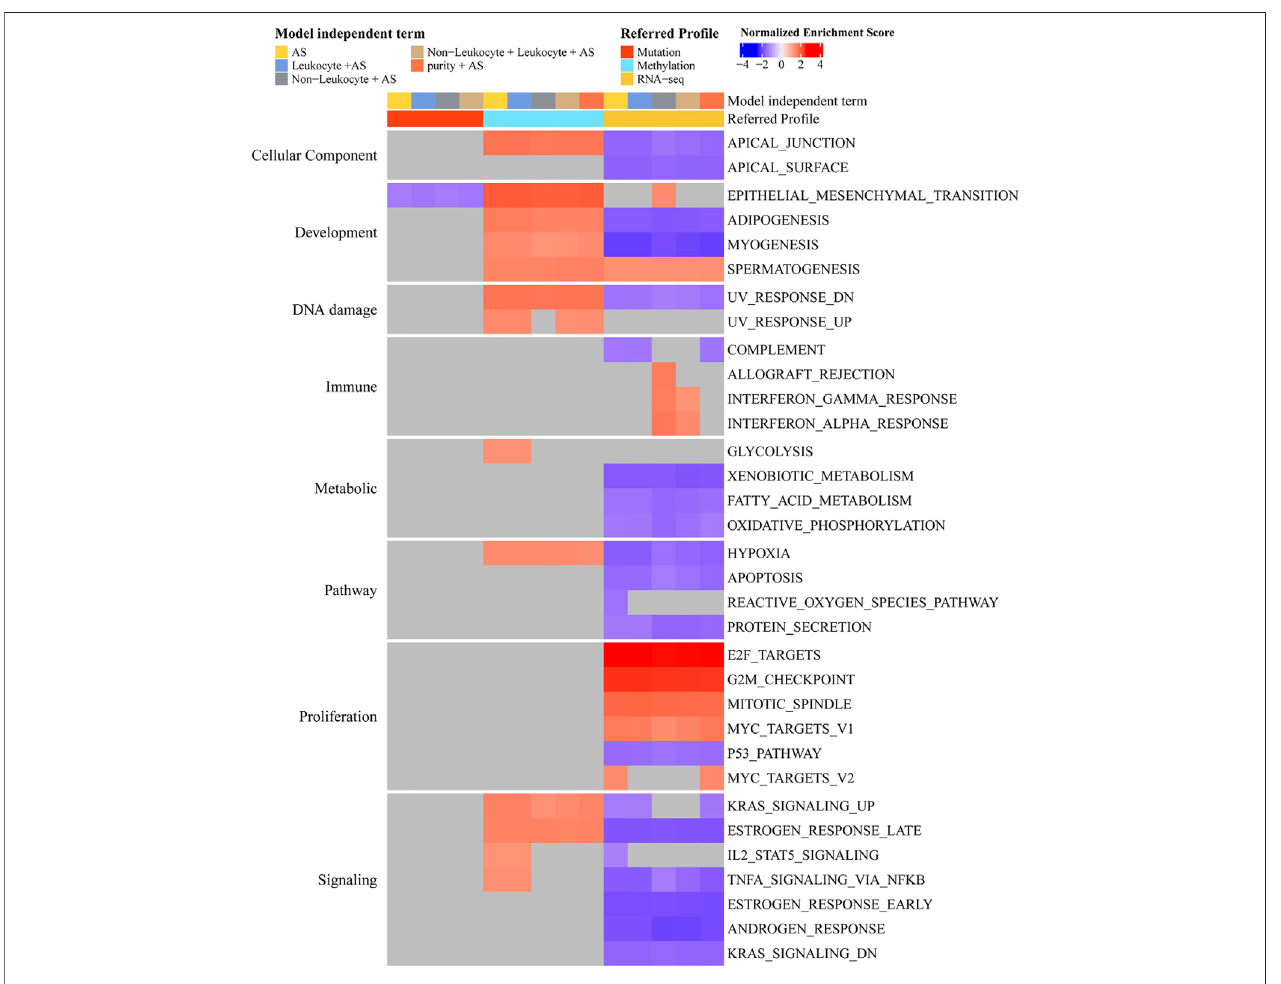
FIGURE 4 | Determination of hallmark function pathway of aneuploidy. Color corresponds to enrichment results of GSEA. Gray means no statistical signi fi cance (adjusted p -value < 0.05).Geneswererankeddecreasinglybasedoncoef fi cientsofASfromlogisticregression(mutationpro fi le)orlinearregression(methylationorgene expression pro fi le); these ordered genes were further entered into GSEA algorithm. By adding purity, leukocyte fraction, or non-leukocyte stroma fraction into model- independent terms, we could adjust their effects. Model-independent terms describe predictor variables included in logistic or linear regression models.